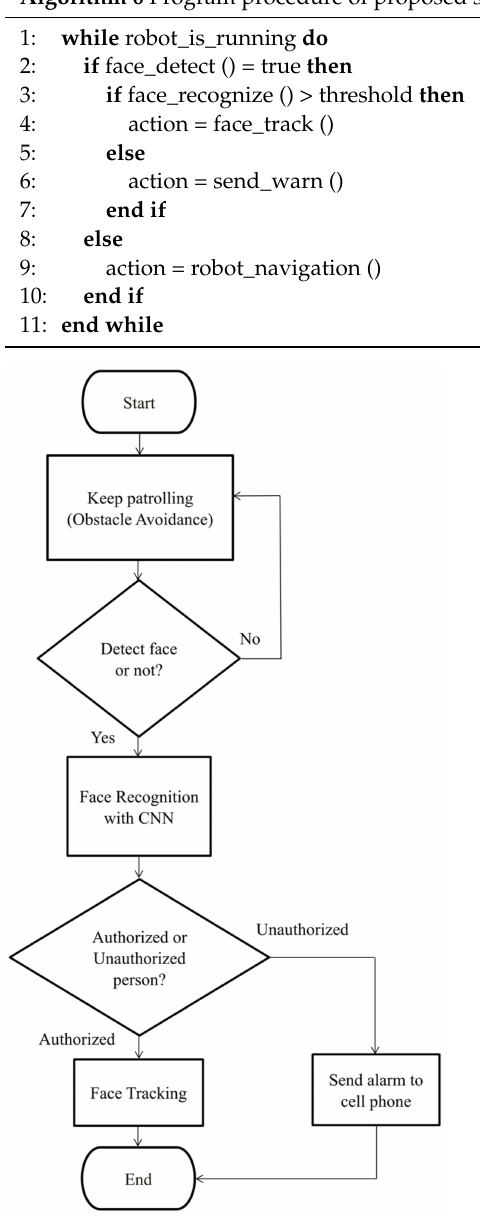
Figure 11. Program flow